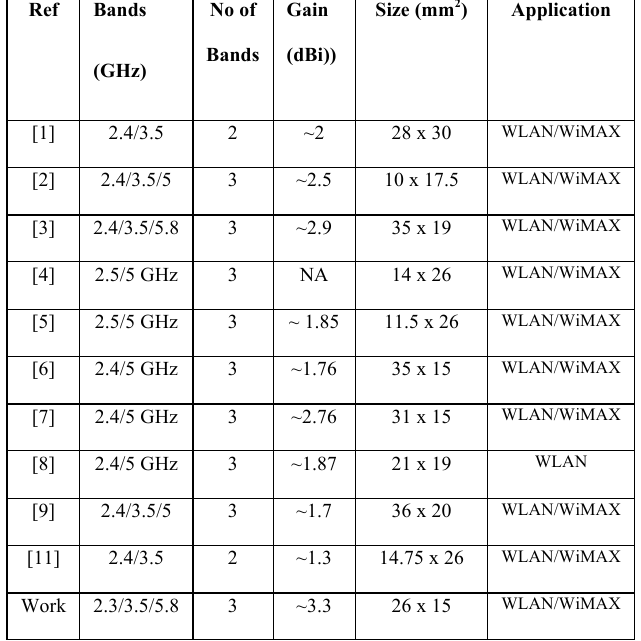
Figure 1: (a) Microstrip Feed (b) CPW Feed (c) ACS Feeding (almost size reduction of 44%) Table 1: Summary of